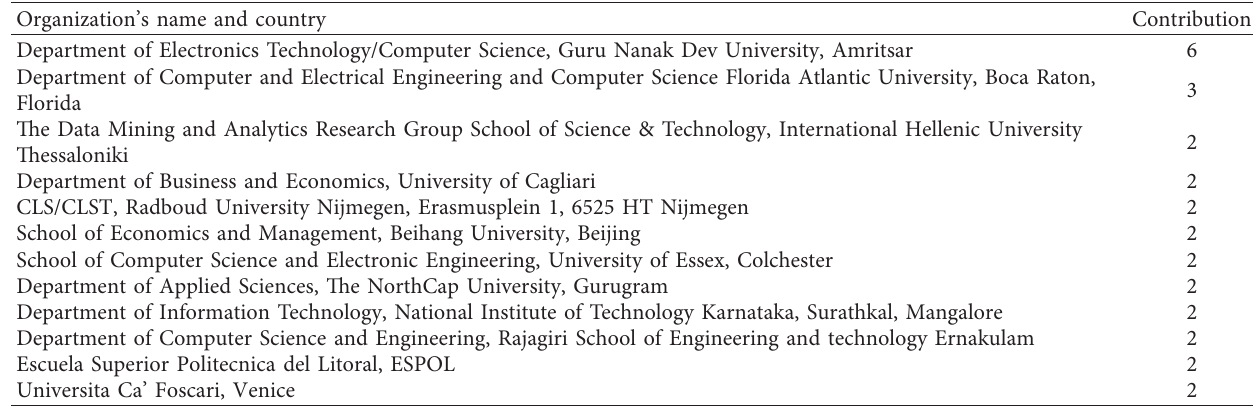
Table 7: Most active